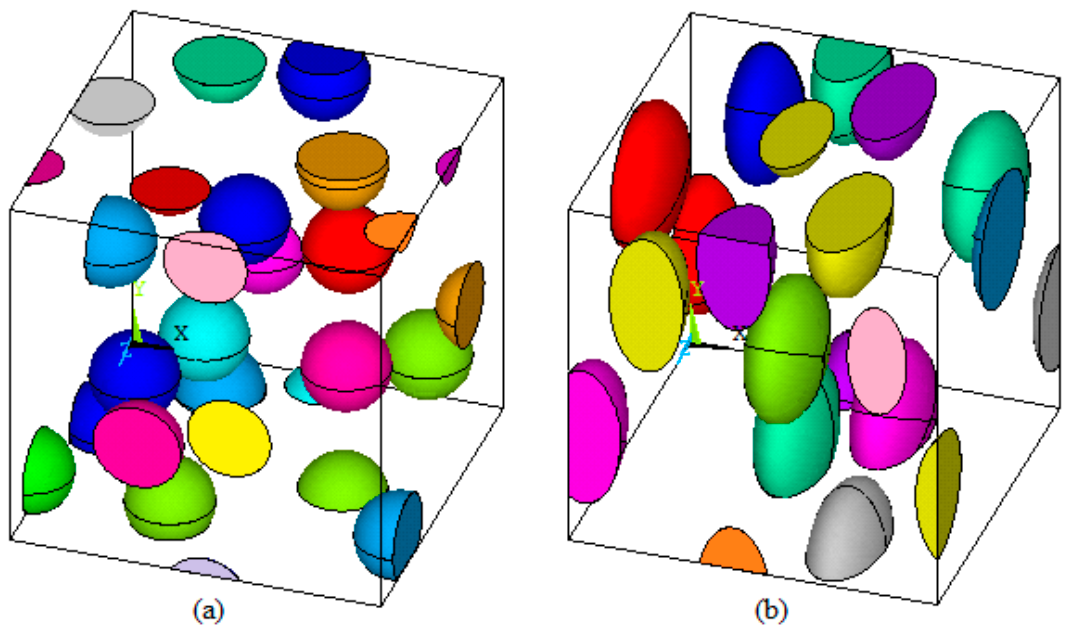
Figure 3. Example of RVE models for different types of particles: ( a ) sphere, ( b ) ellipsoid.